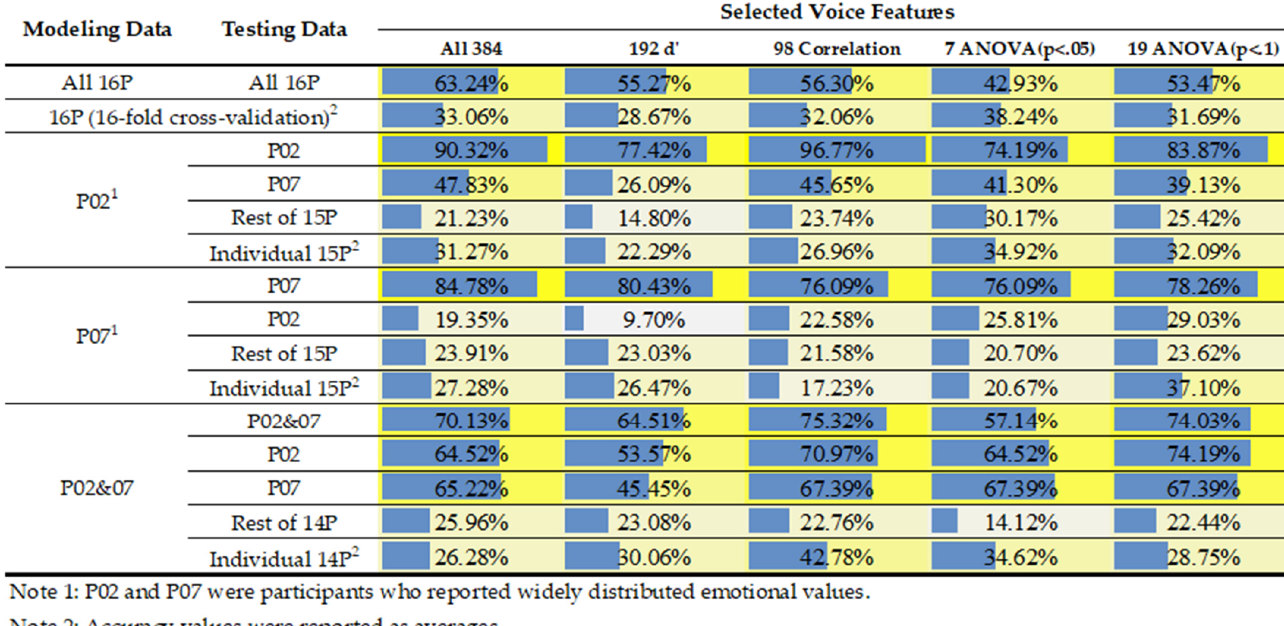
Figure 2. Comparison of modeling accuracy of using a variety of data set. A longer blue bar indicates a relatively higher accuracy rate, and a brighter yellow shade indicates a better modeling performance.